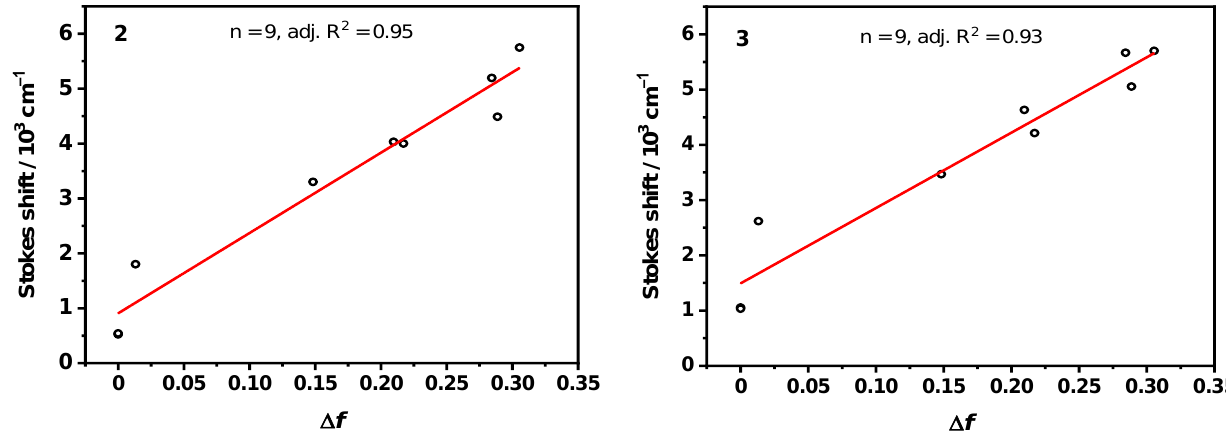
Figure 5. Lippert–Mataga plots of compounds 2 ( left ) and 3 ( right Figure 5. Lippert – Mataga plots of compounds 2 ( left ) and 3 ( right ).